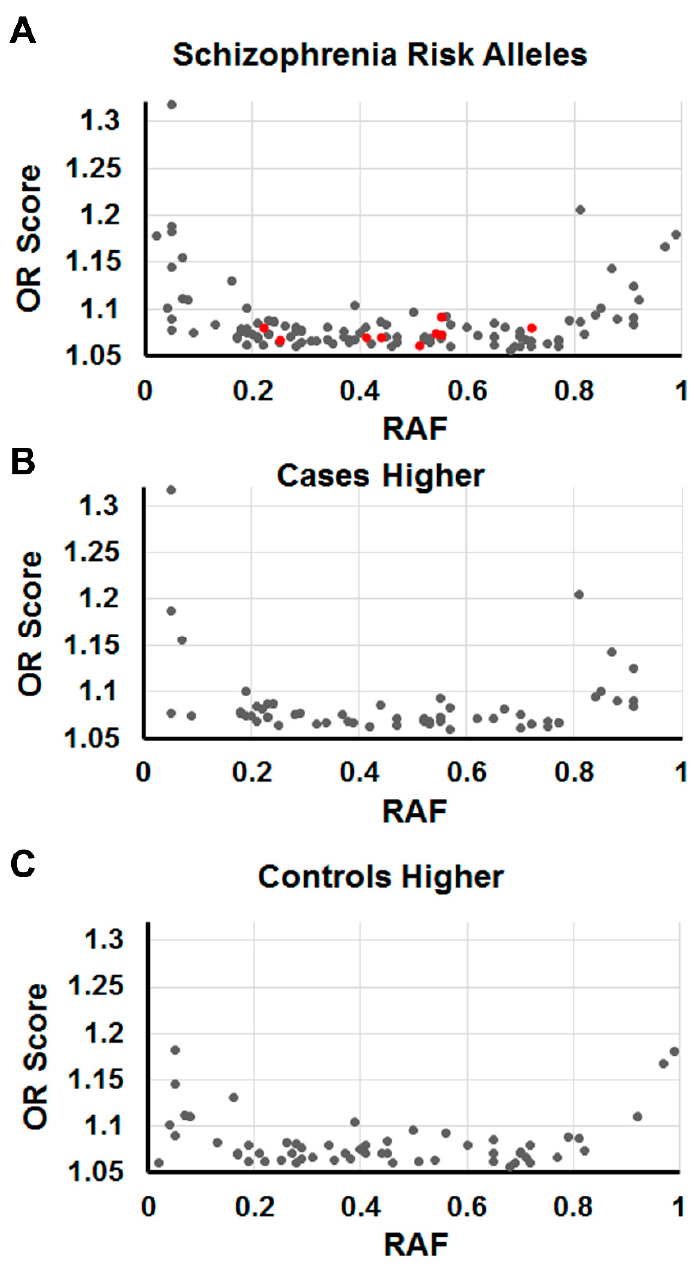
Figure 1. Distribution of OR scores as a function of RAF for the PGC risk alleles. ( A ) Data from 114 risk alleles are plotted. The red circles represent SNPs associated with functional syntenic blocks as described in the text. ( B ) Plots of 57 SNPs that occurred more frequently in cases of schizophrenia than controls, and ( C ) 57 SNPs that were higher in controls than cases. It is worth noting that the case and control distributions are superficially very similar to each other.